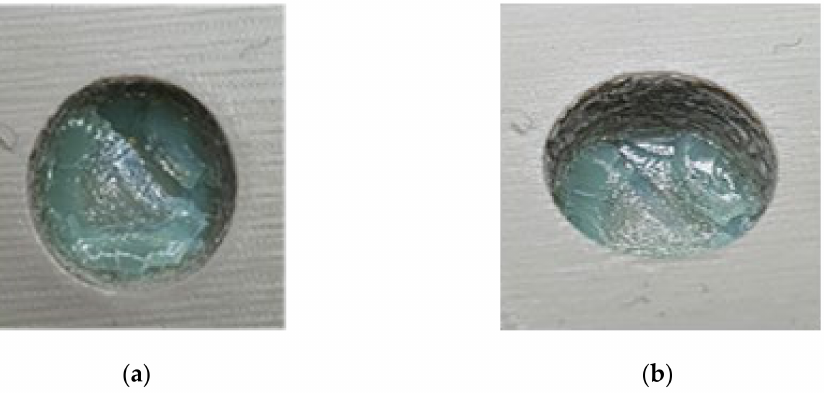
Figure 27. ( a ) Top view of M5 core on pin 8th part showing a small chunk of green 3DIM material of core pin stuck inside; ( b ) orthographic view of M5 core hole on 8th part showing a small chunk of green 3DIM material of core pin stuck inside.